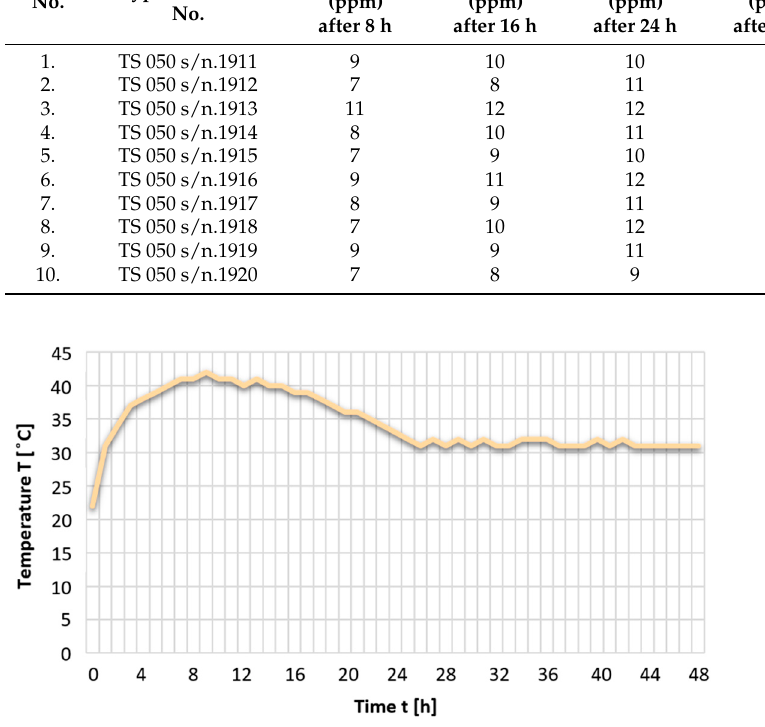
Table 9. Values of natural BR TS 050 frequencies measured after the trial run (configuration B). No. Type BR/Serial No.